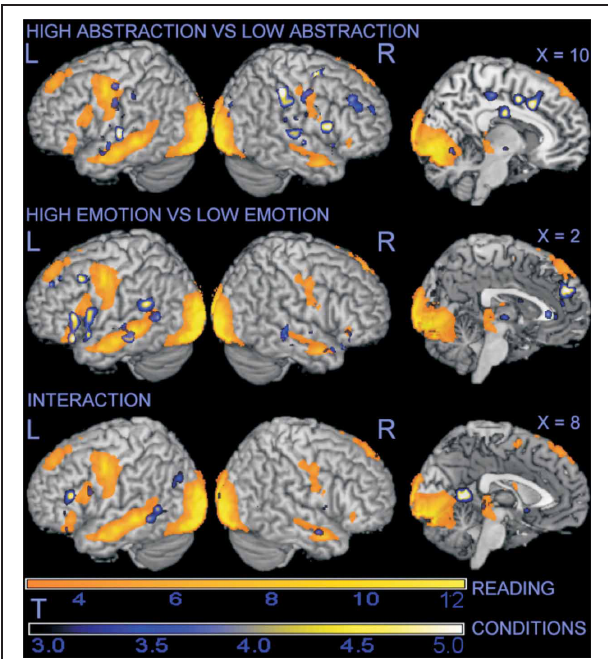
FIGURE 2 | Surface rendering projection of statistical maps associated with contrasts in the whole-brain analysis. The large yellow/orange areas illustrate the activation elicited by the main task of reading stories, irrespective of content. Modulation of signal by abstraction, emotion, and their interaction is superimposed in blue/yellow. For illustration purposes, statistical maps were thresholded at p = 0 . 005,